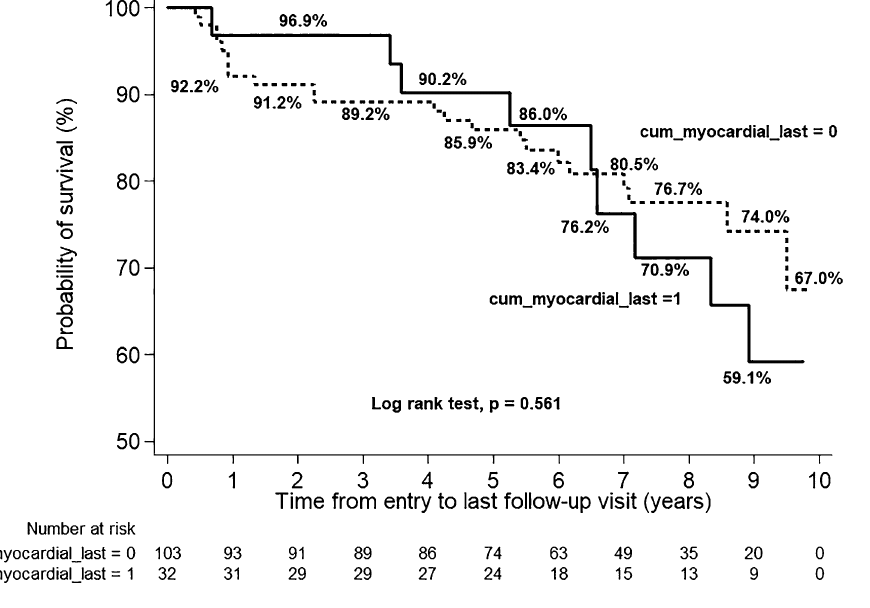
Figure 2. Estimated survival between SSc-CM and SSc without